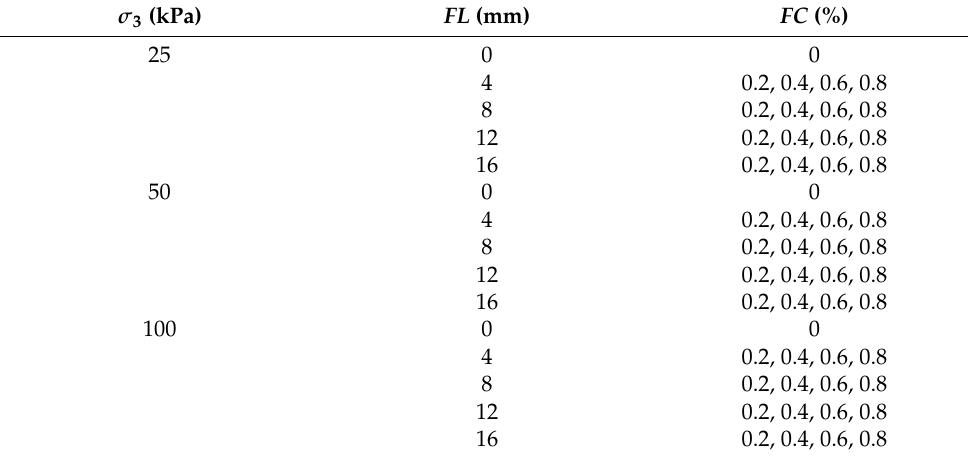
Figure 2. Triaxial testing equipment. Table 3. Test